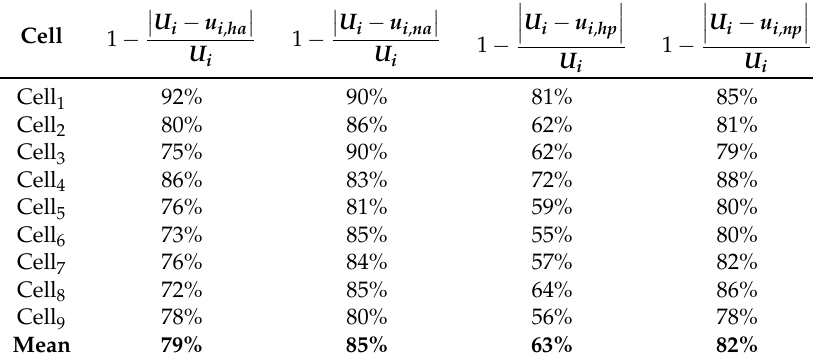
Table 7. The accuracies of vehicle speed estimation of each road